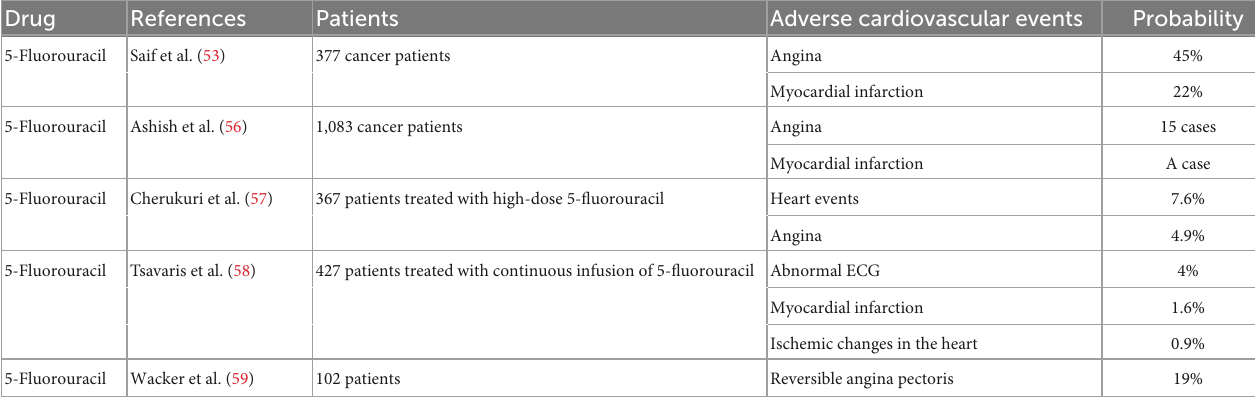
TABLE 5 Summary of clinical studies on cardiotoxicity of 5-fluorouracil.